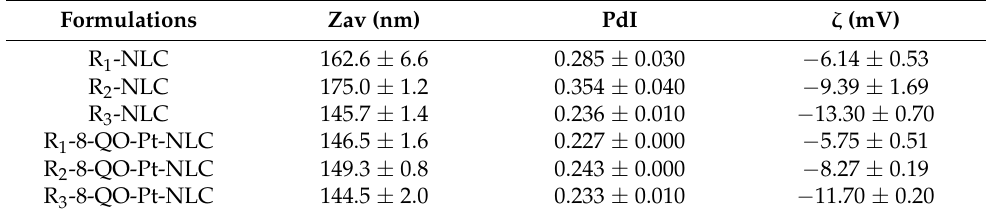
Table 2. Zav, PdI, and Z-pot of NLCs obtained by DLS. Zav: average size (nm); PdI: polydispersity index; Z-pot: ζ (mV). All values are the mean and standard deviation ( n = 3).